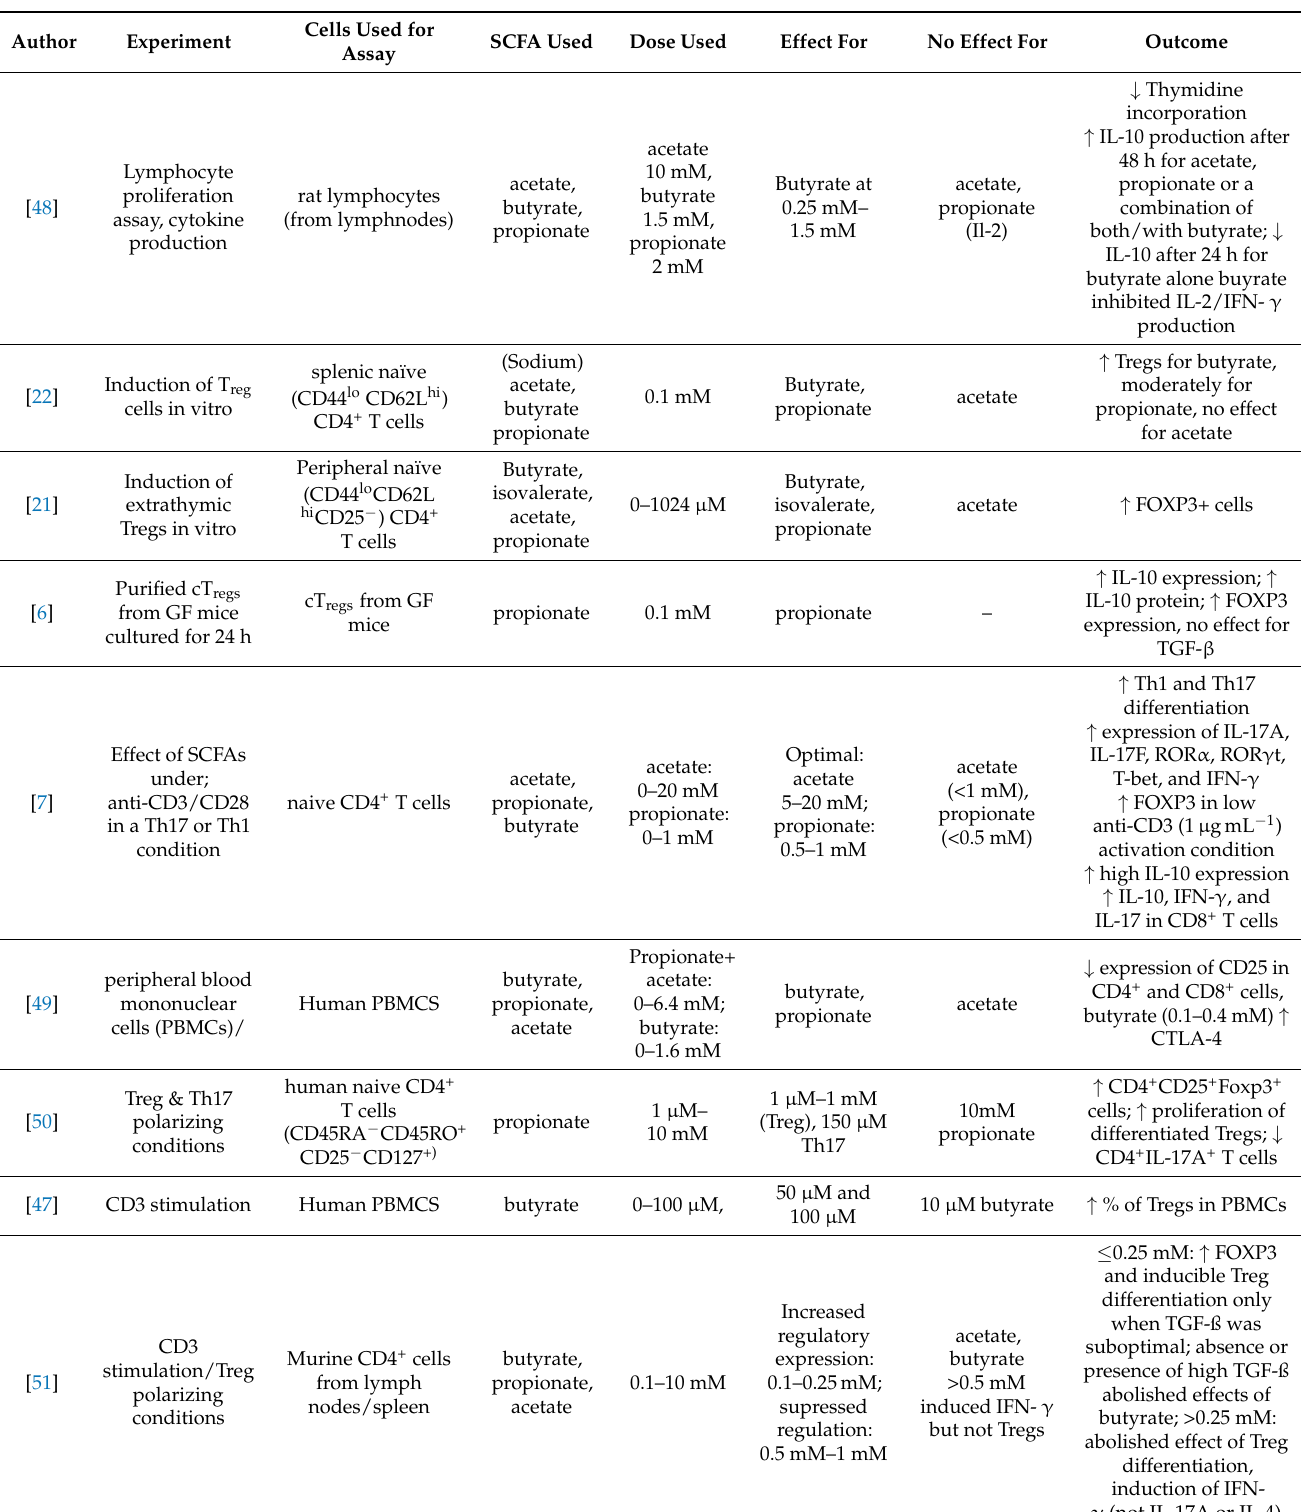
Table 2. Concentrations used in pivotal studies with in-vitro experiments with Treg/Th17 cells in humans and